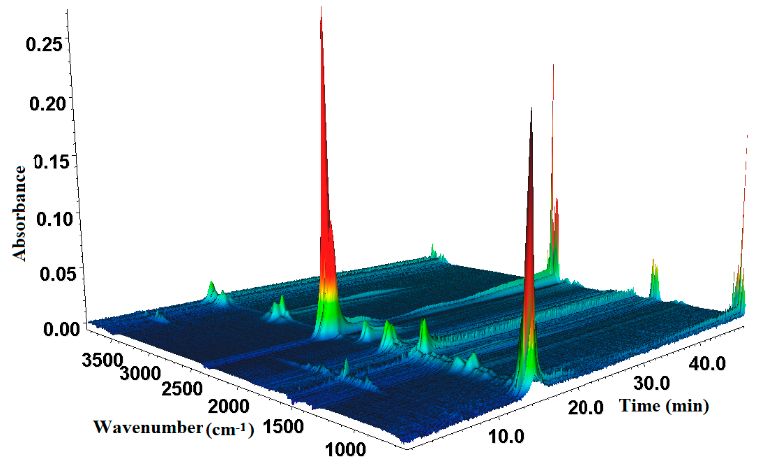
◦ C min − 1 heating 2 atmosphere, 20